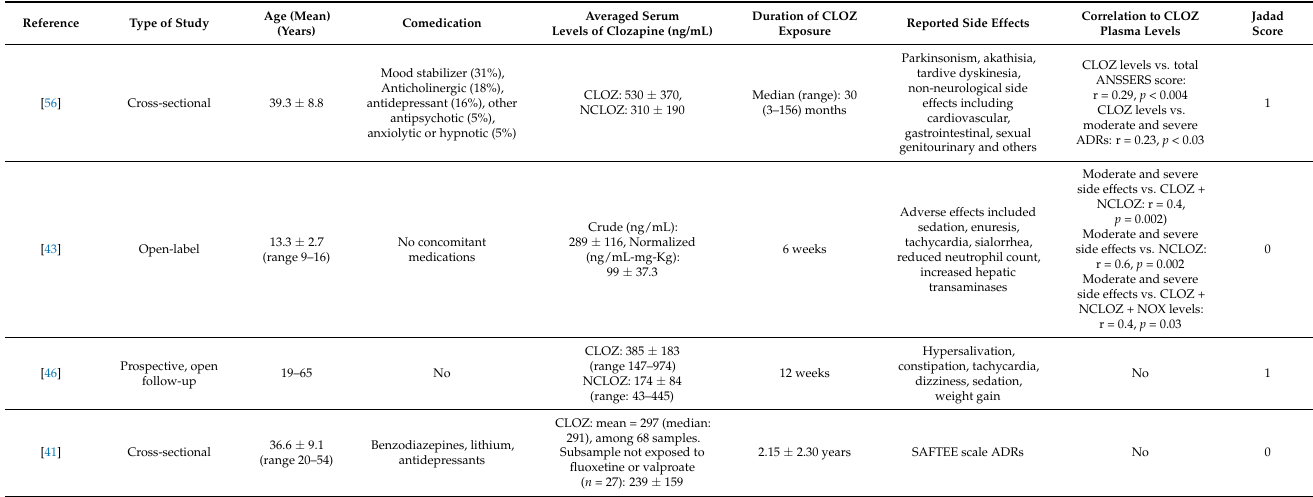
Table 2. General scores of adverse effect scales or combinations of adverse effects in relation to clozapine plasma